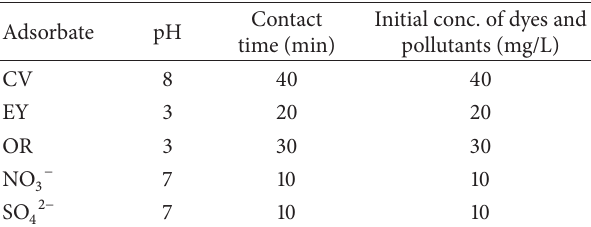
Table 1: Optimal reaction parameter conditions for maximum percentage removal of dyes and inorganic